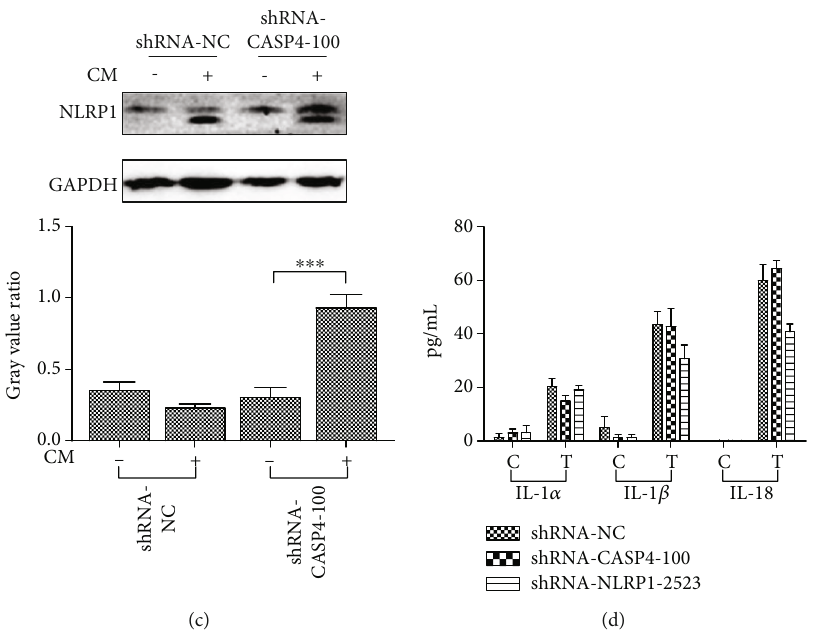
Figure 6: Study on the e ff ect of CASP4 and NLRP1 genes on MCF7 pyroptosis induced by hUCMSC-CM. (a) The western blotting results of pro-CASP1, cleaved-CASP1, and ASC proteins. (b) The western blotting results of pro-CASP4 and cleaved-CASP4. (c) The western blotting results of NLRP1. (d) The concentration of secreted cytokine in cell supernatant. NC: negative control. CM-: cells were collected after transfection with shRNA vector for 72 h. CM+: cells were collected after transfection with shRNA vector for 72 h and treated with hUCMSC-CM for 24h. C: cells were collected after transfection with shRNA vector for 72h. T: cells were collected after transfection with shRNA vector for 72h and treated with hUCMSC-CM for 24 h. Data were presented as mean ± SD of three independent experiments. ∗ P < 0 : 05 , ∗∗ P < 0 : 01 , and ∗∗∗ P < 0 : 001